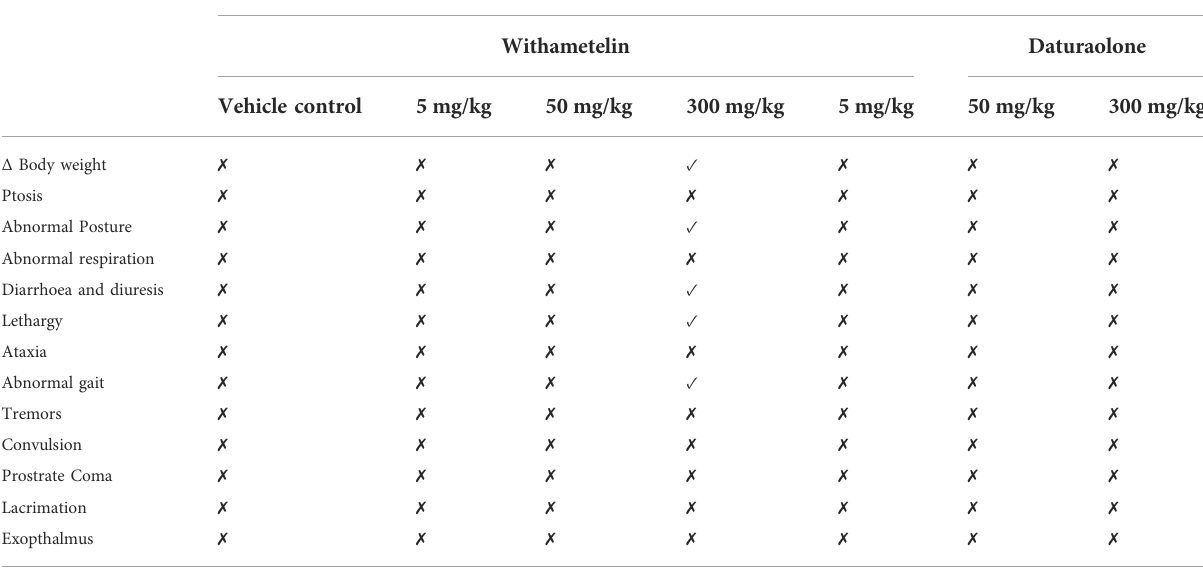
N = 4. 7 = absent, ✓ = present.